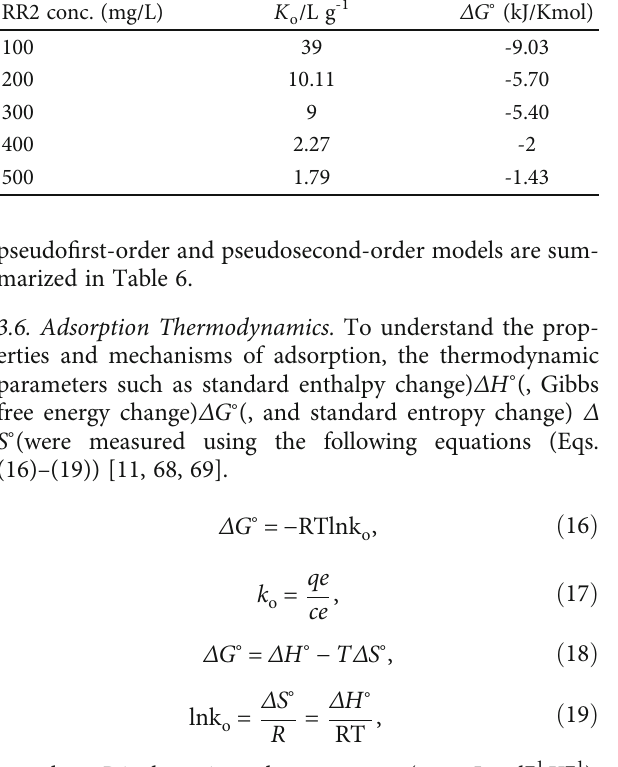
Table 7: Thermodynamic parameters for the adsorption of RR2 on GWAC at 24 ± 2 ° C